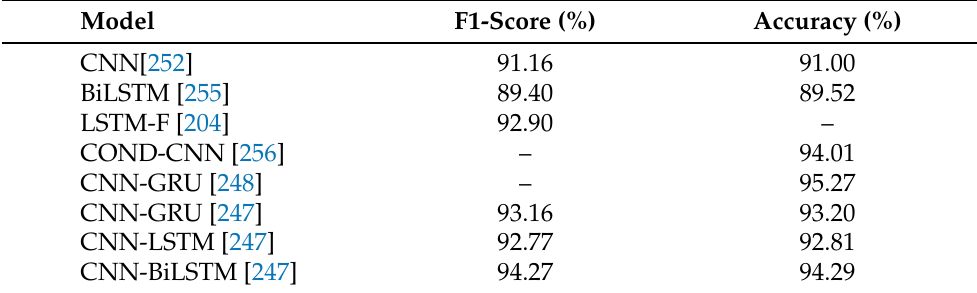
Table 4. Comparison of models on PAMAP2